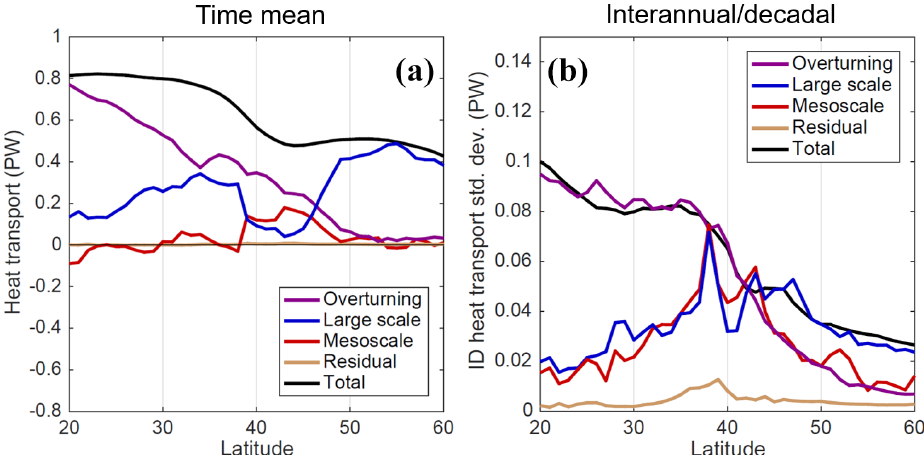
Figure 4. (a) POP time-mean contributions to meridional heat transport (MHT) in the North Atlantic from overturning, large-scale, and mesoscale components, and the unexplained residual, as a function of latitude. (b) Standard deviation (on interannual/decadal timescales) of the components of MHT.